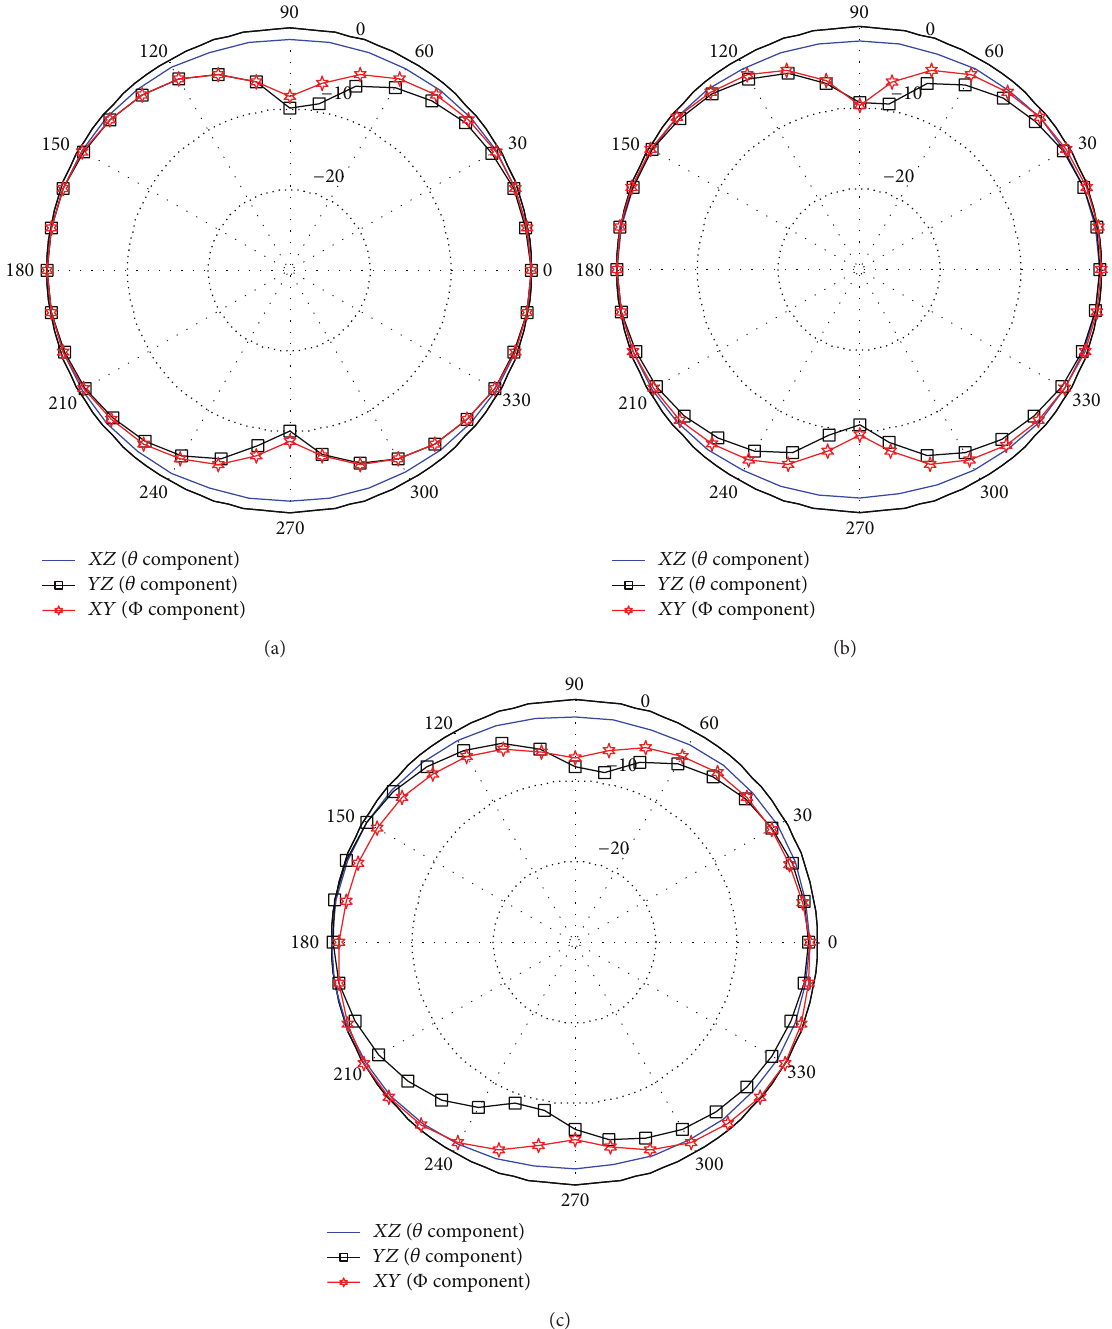
Figure 10: Measured radiation pattern for three principle planes (a) 2.4 GHz, (b) 3.5 GHz and (c) 5.8